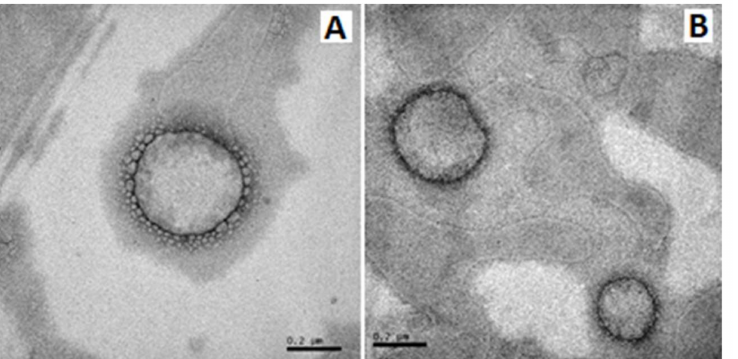
Figure 2. Photomicrographs obtained by transmission electron microscopy at 80 kV, with a magni- fication of 100,000 × . ( A ) Toltrazuril-loaded lipid core nanocapsule (LNCt); ( B ) Toltrazuril-loaded Eudragit ® S100 nanocapsule (NC S100 t). Bar equal to 0.2 µ